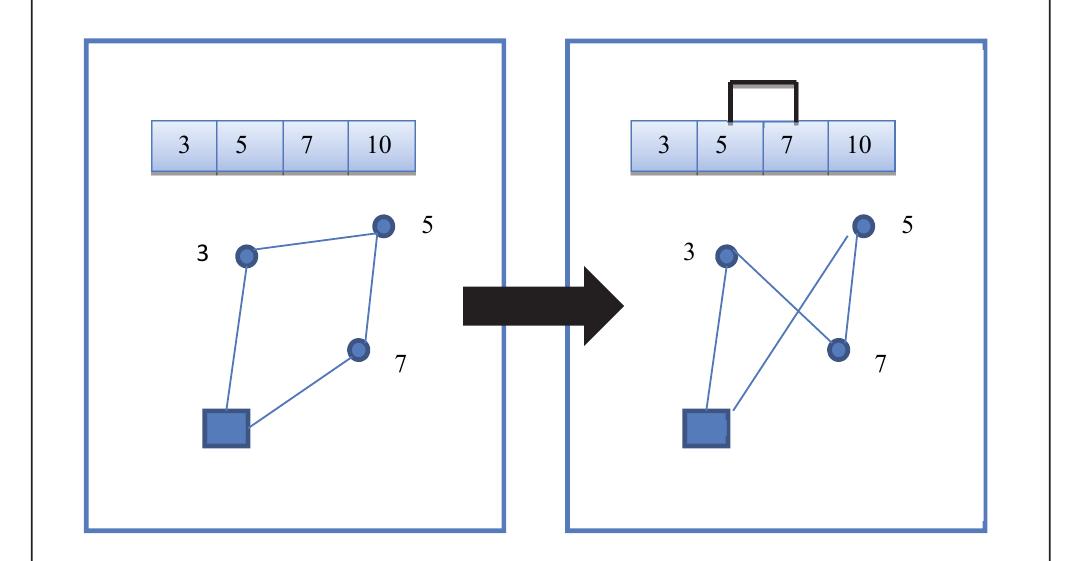
Fig. 3 . Transformation rule for generating neighbors